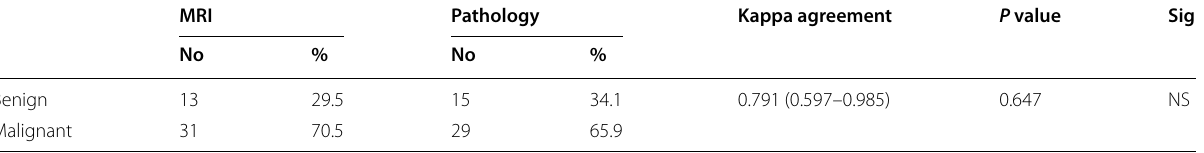
P value > 0.05: non-significant (NS); P value < 0.05: significant (S); P value < 0.01: highly significant